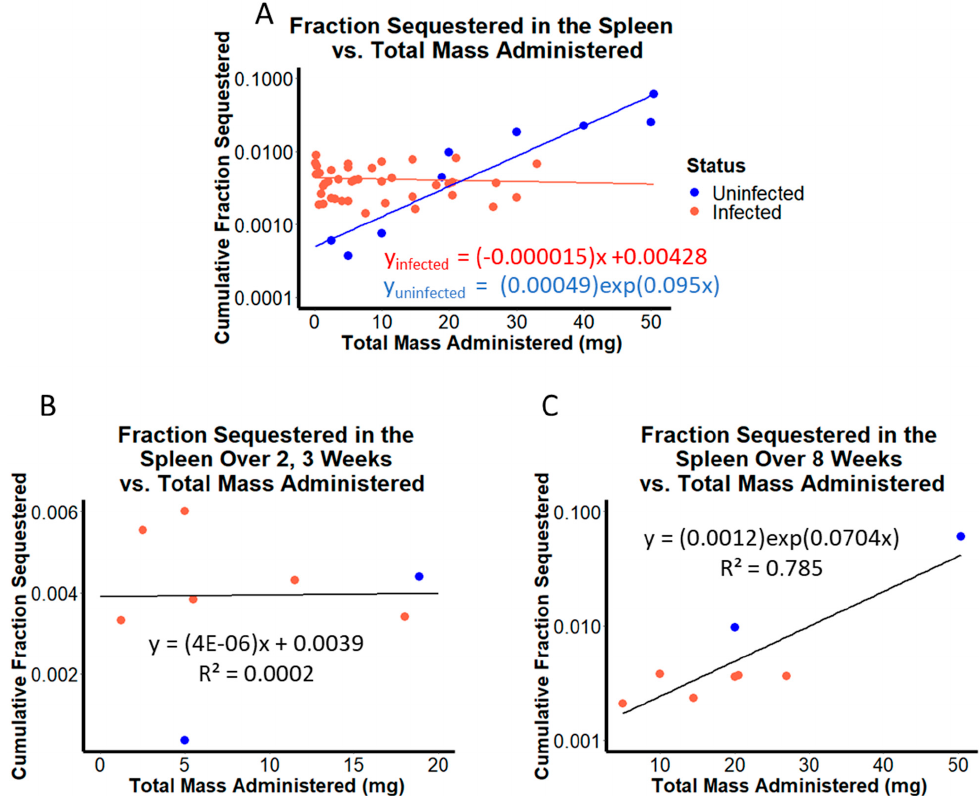
Figure 5. ( A ) Cumulative fraction sequestered in the spleen as a function of total CFZ administered across 8 dosing regimens in M. tuberculosis infected (red) and uninfected (blue) BALB/c mice. ( B ) Cumulative fraction sequestered after 2 or 3 weeks of drug loading at each of the 8 dosing regimens compared to the total drug administered. ( C ) Cumulative fraction sequestered after 8 weeks of drug loading at each of the 8 dosing regimens compared to the total drug administered.